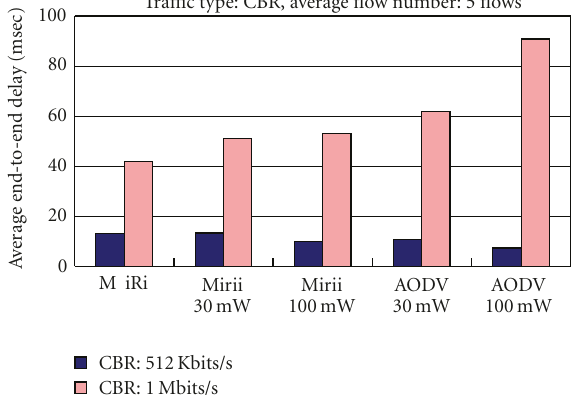
Figure 11: Average end-to-end delay of di ff erent